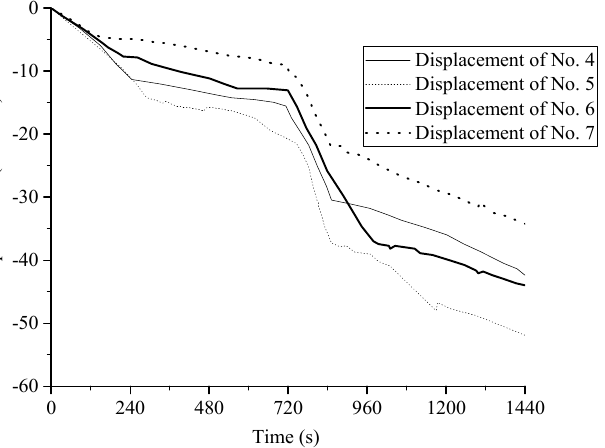
Figure 5. Relation between ground displacement and time of first-down and then-up crossing.